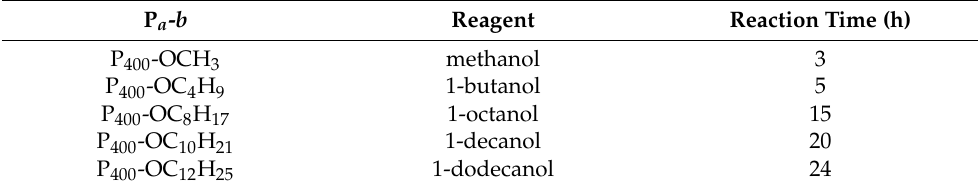
Table 2. Reaction time of the alkylation of POEHP.